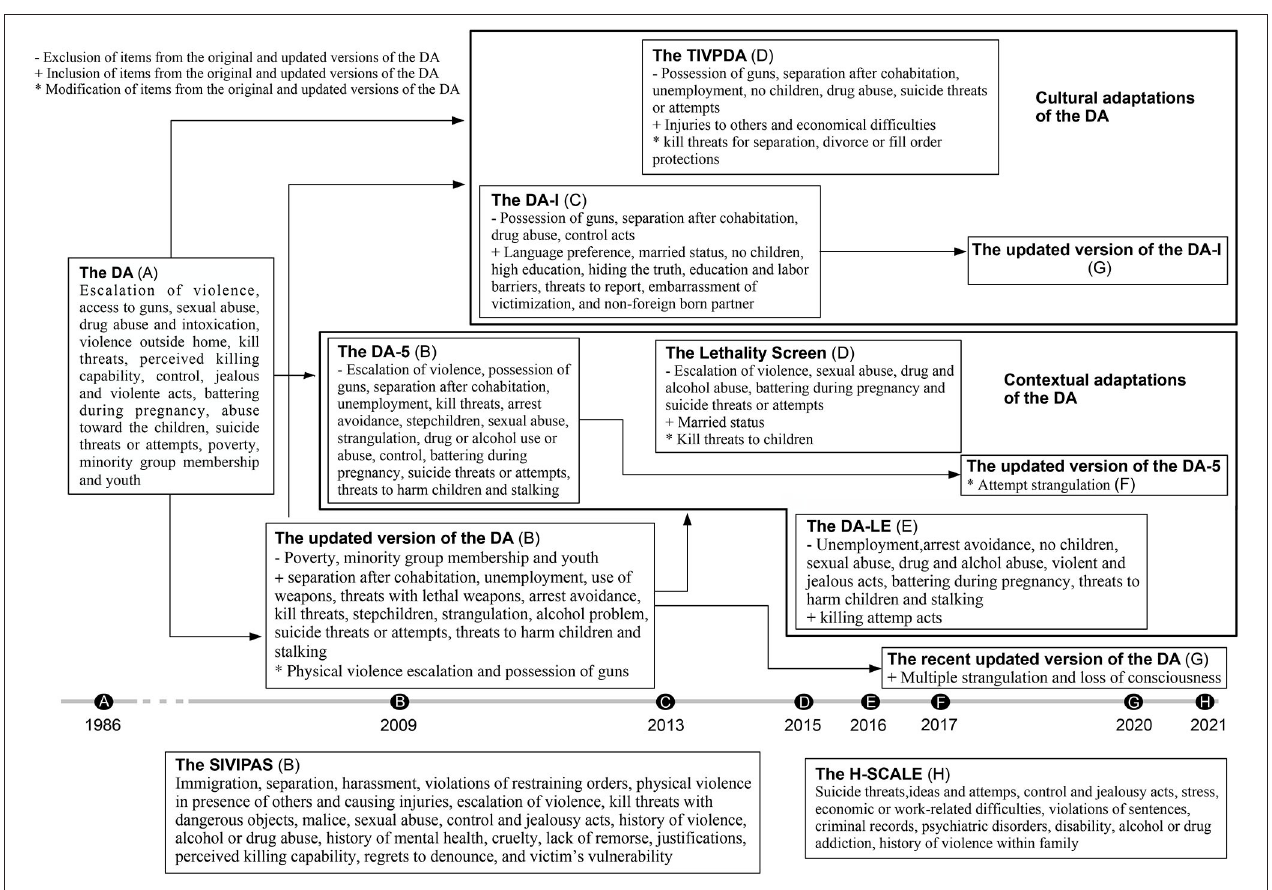
FIGURE 2 | Evolution of the instrument’s risk factors